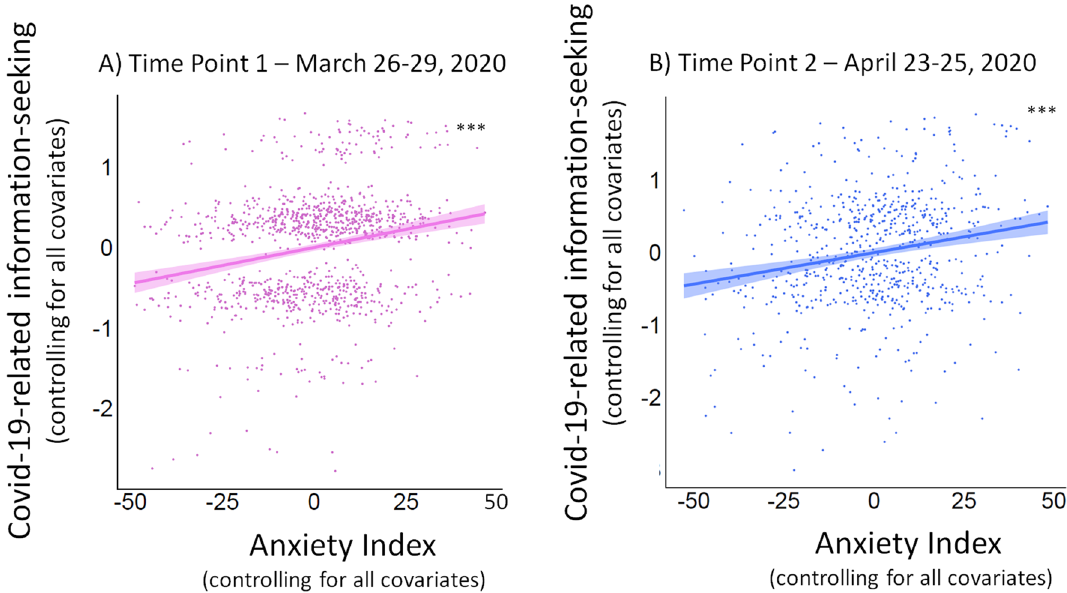
Figure 1. Individuals reporting greater Covid-19-related anxiety sought more Covid-19-related information (Study 1). Plotted are the partial linear regressions predicting self-reported Covid-19-related information- seeking (obtained by asking participants “How often do you consume information on COVID-19 (news, internet etc ..)?” on a scale from “Never” (0) to “At least once an hour” (6) on a discrete scale) from the Anxiety Index Score (obtained by summing the COVID-19-related anxiety questions and the SSAI score and dividing by the total number of questions) at Time Point 1 ( A ; p < 0.001) and Time Point 2 ( B ; p < 0.001), controlling for age, gender, level of education, household income, political orientation, ethnicity, whether they had dependents and the satisfaction with their health insurance. Both graphs show that individuals with higher Anxiety Index Score report engaging more in COVID-related information seeking. ***p < 0.001. (Note that the observed clustering along the Y-axis in both graphs is due to the discrete nature of the rating scale used to measure Covid-19-related